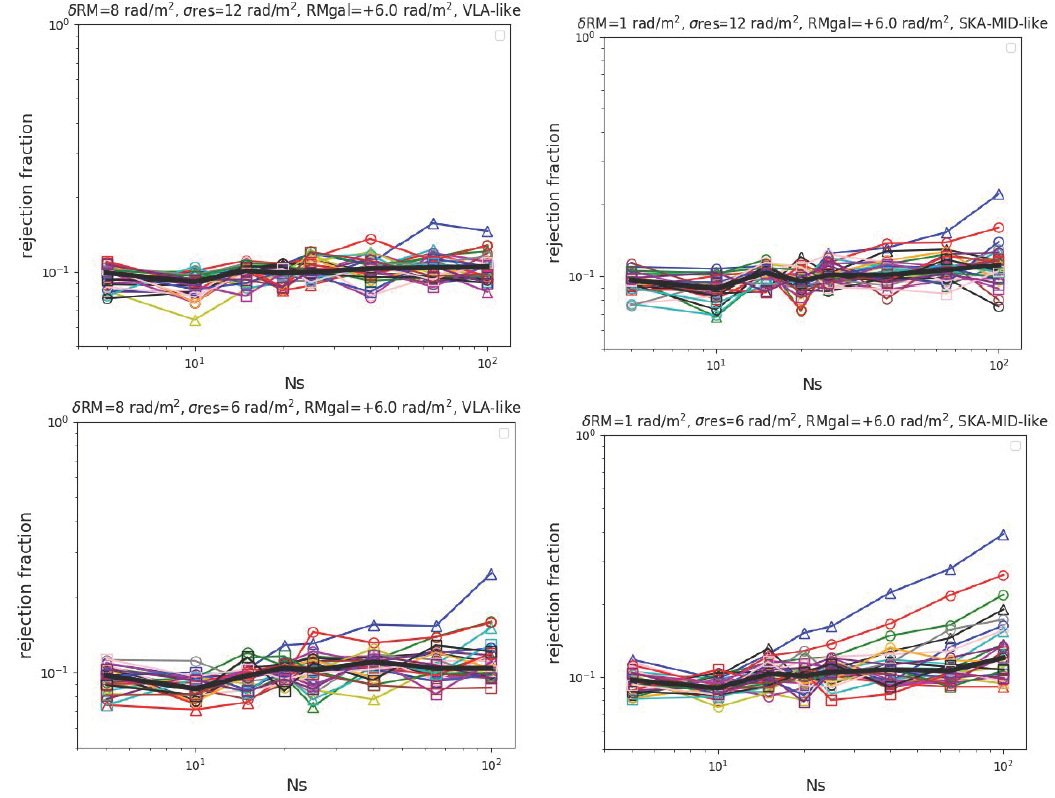
Figure 3. Rejection fraction for an increasing number of detected RM as in Figure 2, but by assuming σ res = 12 rad/m 2 for the residual RM of sources (top panels), while the lower panels we assumed σ res = 6 rad/m 2